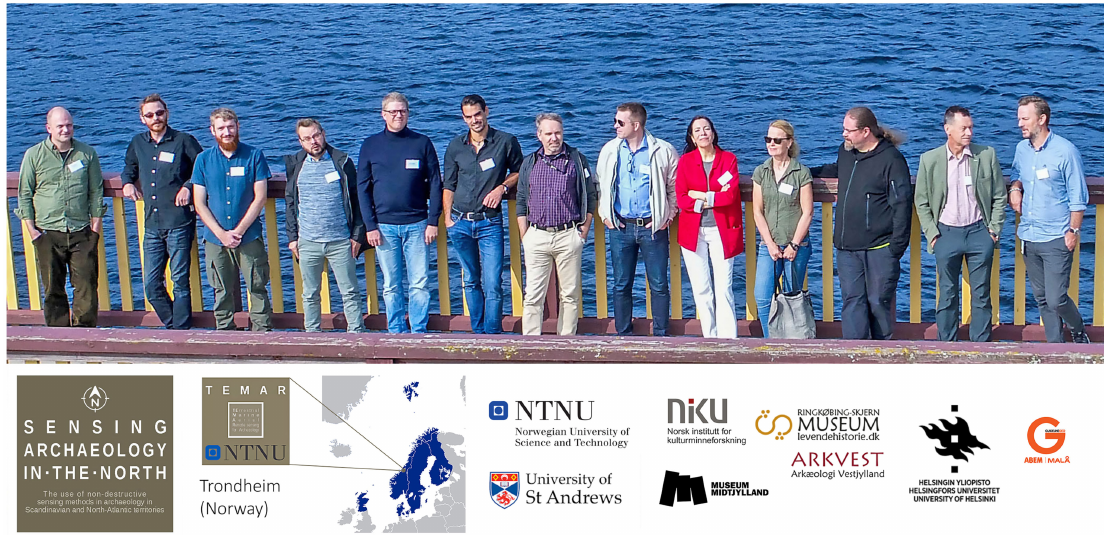
Figure 1. Participants of the workshop ‘Sensing Archaeology in the North’ . From left to right: Esben Schlosser Mauritsen (Denmark), Dag-Øyvind Solem (Norway), Mikkel Fuglsang (Denmark), Arne Anderson Stamnes (Norway), Andreas Viberg (Sweden), Manuel Gabler (Norway), Ole Risbøl (Norway), Øyvind Ødegård (Norway), Carmen Cuenca-García (Norway), Satu Koivisto (Finland), Wesa Perttola (Finland), Richard Bates (Scotland), Fredrik Skoglund (Norway). Photo by Raymond Sauvage, NTNU University